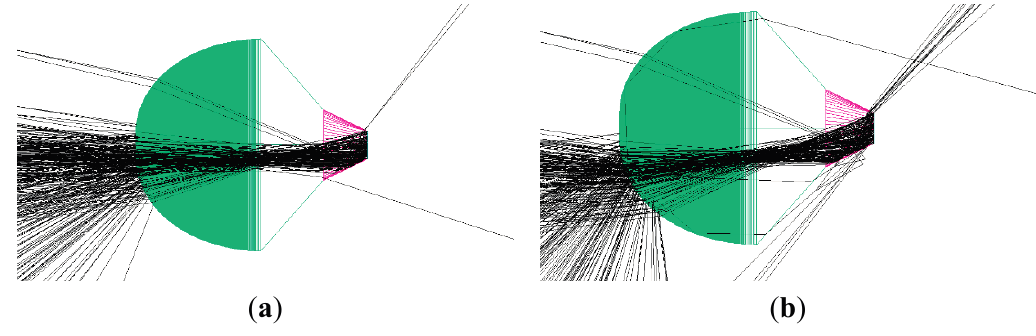
Figure 3. Ray tracing inside the KOD-type SOE ( a ) incidence angle = 0.4°; ( b ) incidence angle of